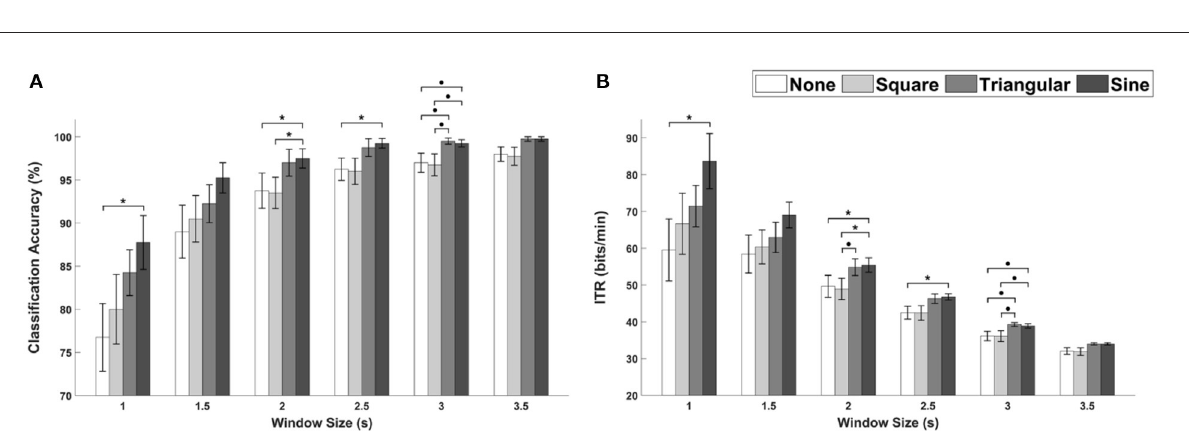
FIGURE5 The average performance of FS-based hybrid visual stimuli in terms of (A) classification accuracies and (B) ITRs as a function of waveforms with different window sizes. Error bars represent the standard errors. Here, • p < 0.1 and * p < 0.05 are the FDRs-corrected p- values from Wilcoxon signed-rank